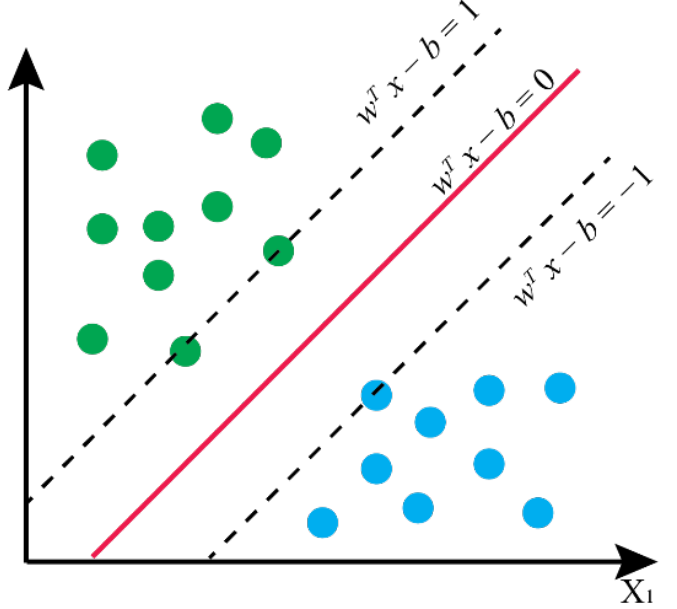
Figure 8. A schematic diagram showing a hyperplane (redline) that separates data points (green and blue dots) from two classes with maximum margin.